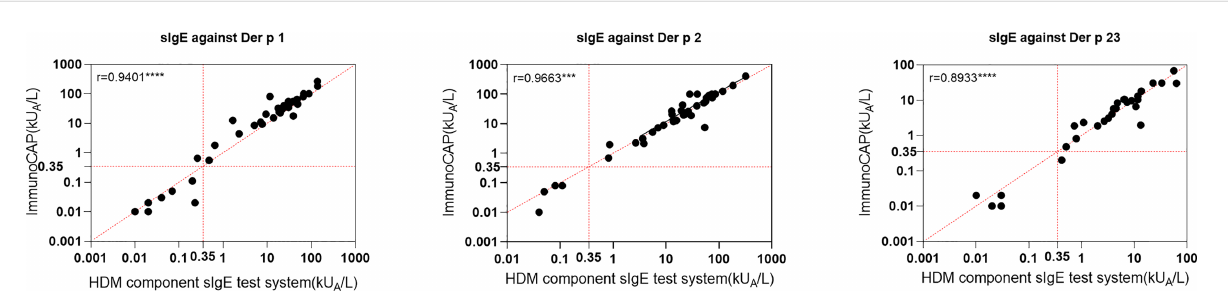
FIGURE 1 Linear regression between house dust mite component sIgE test system in this study and ImmunoCAP for three components. ***p < 0.001; ****p <